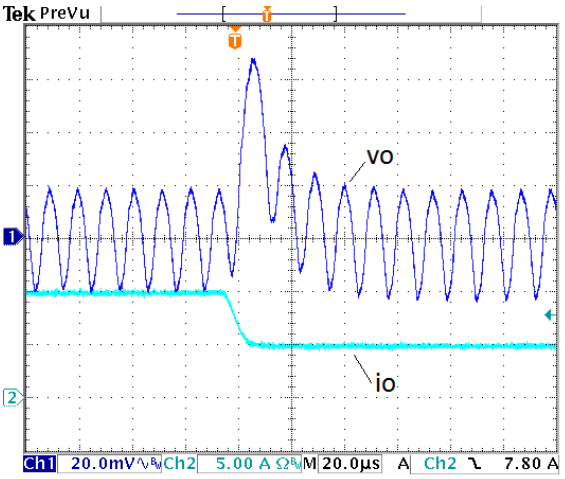
Figure 15. Experimental output voltage response to a load current step in the buck converter from 10 A–5